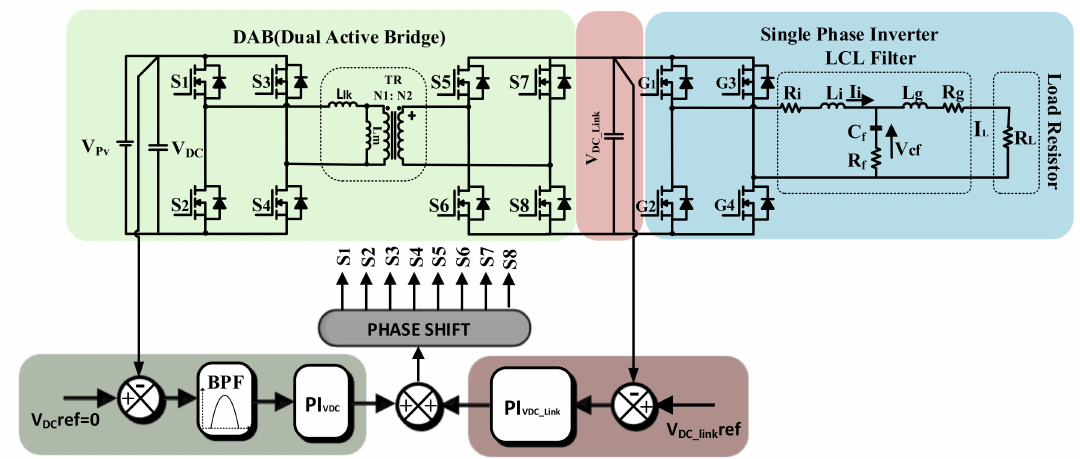
Figure 2. Two-stage single-phase DC / AC converter with the proposed ripple current control